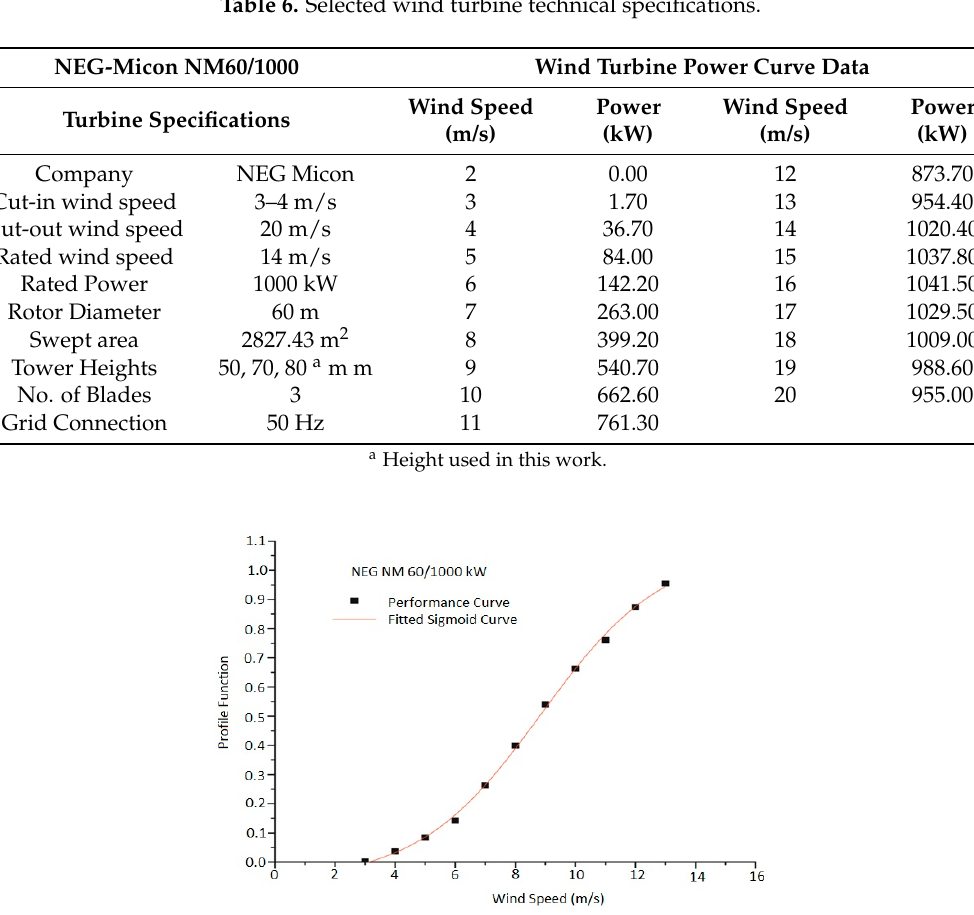
Figure 5. Performance curve for NEG NM 60/1000–250 kW turbine fitted to sigmoid function. Table 7. Weibull wind energy estimation based on MMLM for Baburband at 80 m height for